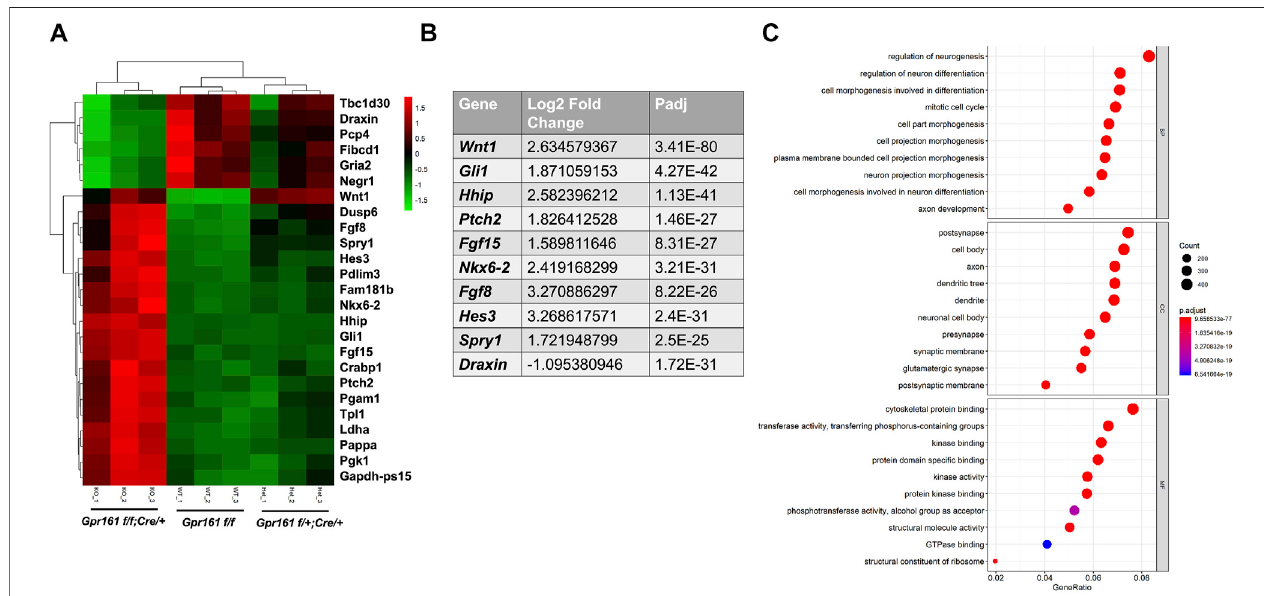
FIGURE 4 | The transcriptomic analysis of the midbrains of Gpr161 cKO fetuses at E13.5. (A) The Heat map from dissected midbrain tissues of Gpr161 f/f ( fl oxed control), Gpr161 f/+ ;Wnt1-Cre/+ ( Cre control) and Gpr161 f/f ;Wnt1-Cre/+ (cKO) fetusesat E13.5(n (cid:1) 3). Top 25DEGs were displayed in Heat map (Top6 downregulated genesinGreenincKOandtop19upregulatedgenesinRedincKO). (B) Toptendifferentiallyregulatedgenes(DEGs)in Gpr161 cKO (C) GeneOntology(GO)analysisof DEGs in Gpr161